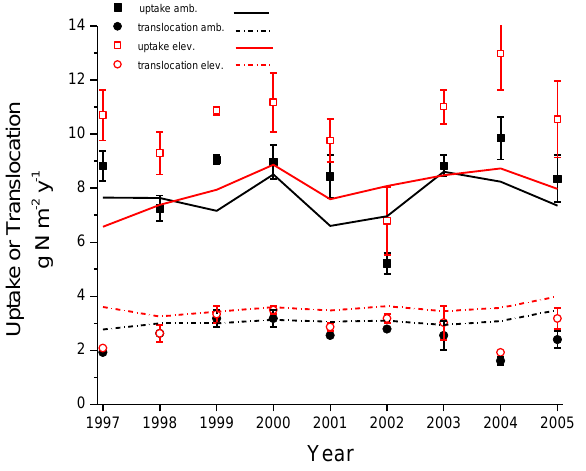
Fig. 4. Fig. 4. Rates of N uptake and translocation estimated from measure- ments (symbols) and modelled (lines) from 1997 to 2004 under am- bient ( ∼ 371µmolmol − 1 ) vs. elevated ( ∼ 571µmolmol − 1 ) C a at the Duke FACE experiment. Estimated values Drake et al. (2011), with error bars representing standard errors from replicated mea- surements ( n = 3).